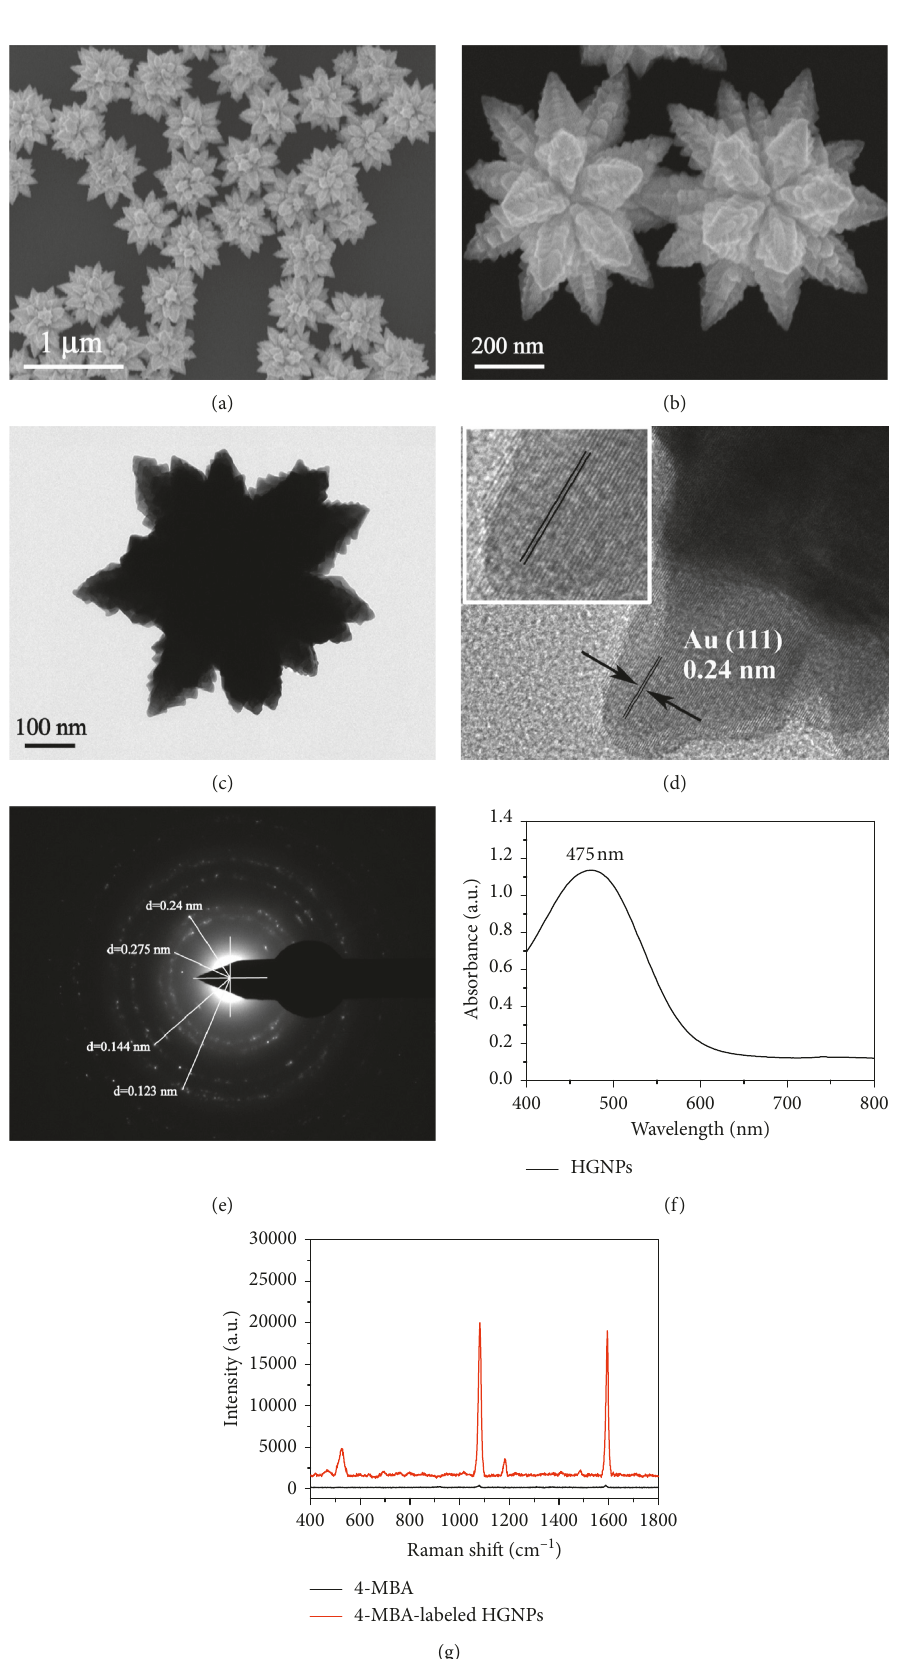
Figure 1: (a) Low and (b) high magnification SEM images of the HGNPs. (c) TEM images and (d) high-resolution TEM images of the HGNPs. (e) SAED pattern and (f) UV-vis-NIR absorption spectrum of the HGNPs. (g) SERS spectra of (black curve) 4-MBA and (red curve) HGNP colloidal dispersion mixed with 4-MBA under 785nm